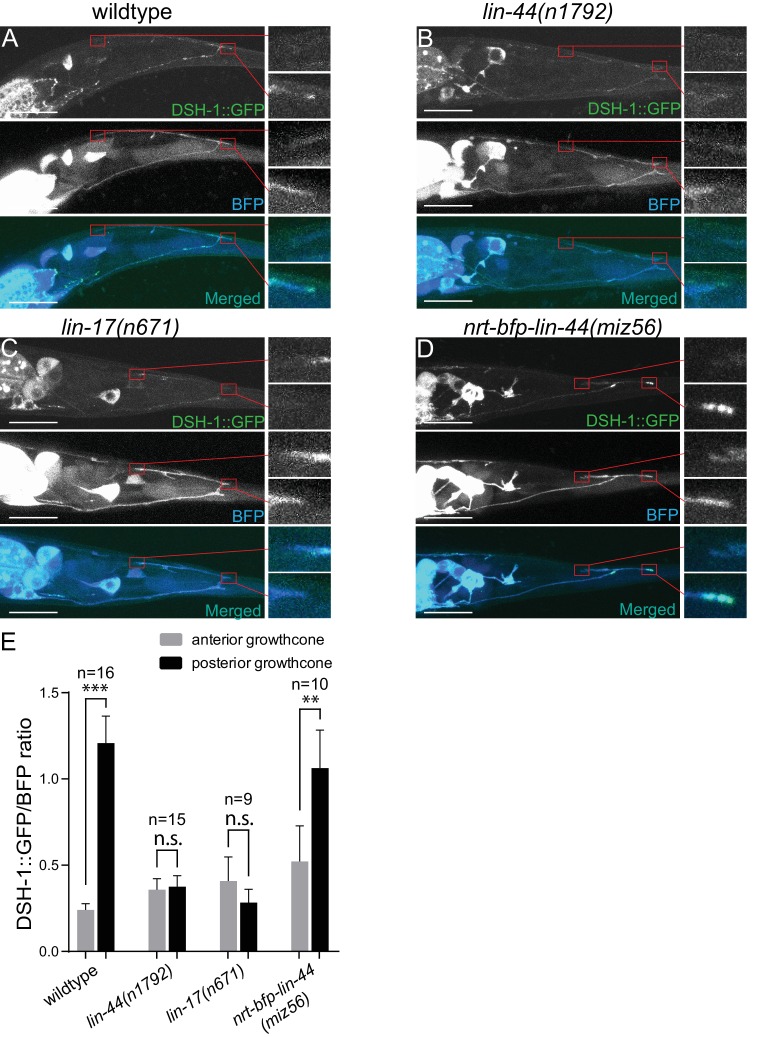
Wnt-dependent localization of DSH-1/Dsh at the PDB posterior neurites.(A–D) Representative images of DSH-1::GFP localization (top panels), PDB neurite structure labeled with cytoplasmic BFP (middle panels) and merged images (bottom panels) in wildtype (A), lin-44(n1792) (B), lin-17(n671) (C) and nrt-bfp-lin-44(miz56) (D) animals, respectively. Magnified images of the tip of anterior and posterior neurites are shown in the right panels. (E) Quantification of the normalized GFP/BFP signal ratio at the anterior and posterior growth cones. Error bars indicate mean ± SEM. ***p<0.001; n.s., not significant (Ratio paired t-test).Figure 7—figure supplement 1—source data 1.Quantification of the normalized GFP/BFP signal ratio at the anterior and posterior growth cones.